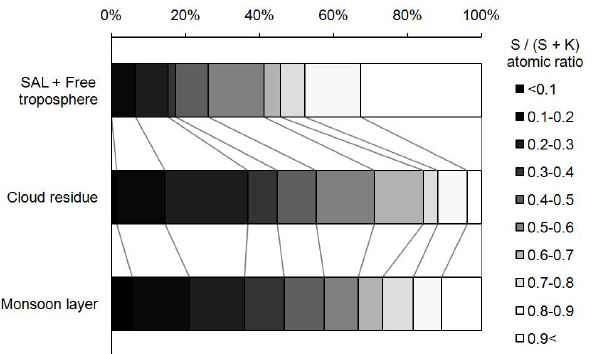
Fig. 10. Variations in atomic ratio (or molar ratio) of S relative to K found within individual biomass burning particles collected during SOP2a2 (monsoon